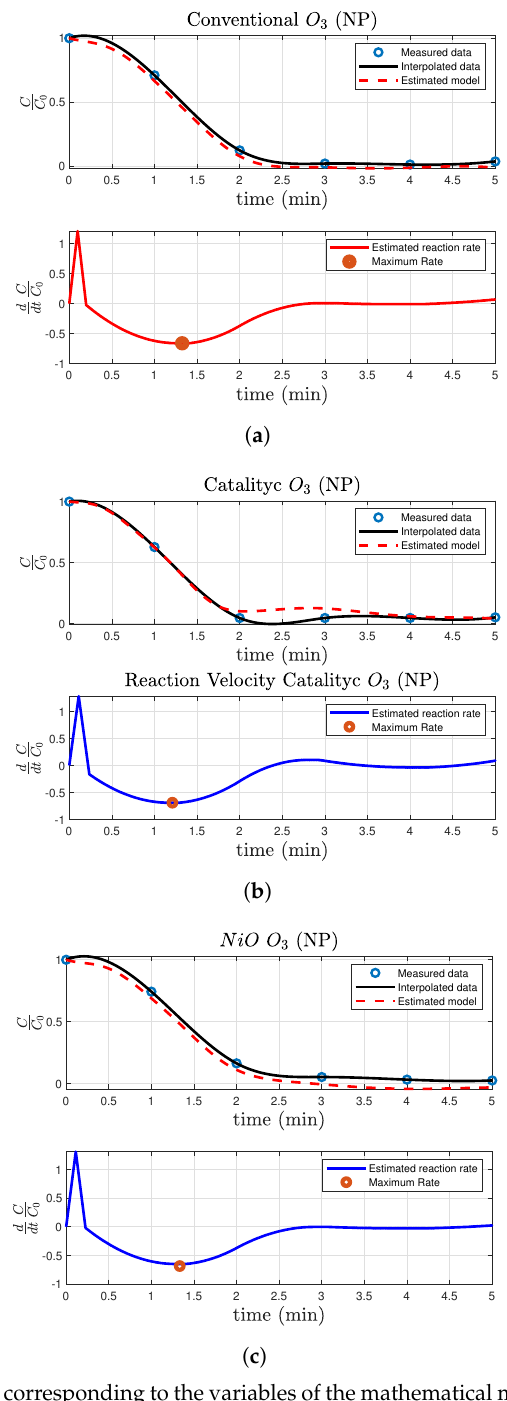
Figure 9. Time evolution corresponding to the variables of the mathematical model and kinetic constant of NP degradation by ozonation. In all the figures the blue circles represent the data obtained by HPLC, the continuous black line represents the interpolated data and the red dotted line describes the model approximation. The second row of graphs depicts the process of kinetic constant estimation based on the STA method: ( a ) O 3 -conv. ( b ) O 3 - NiO ( S ) . ( c ) O 3 - NiO ( P )